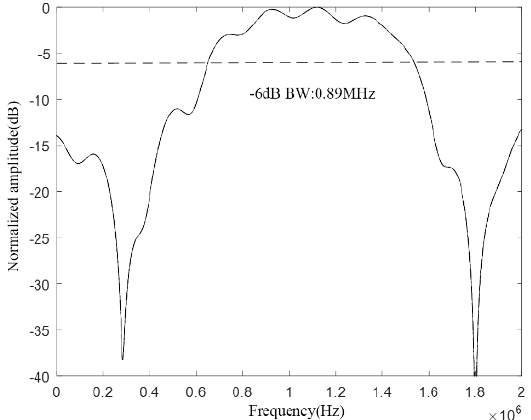
Figure 21. CMUT bandwidth in water.